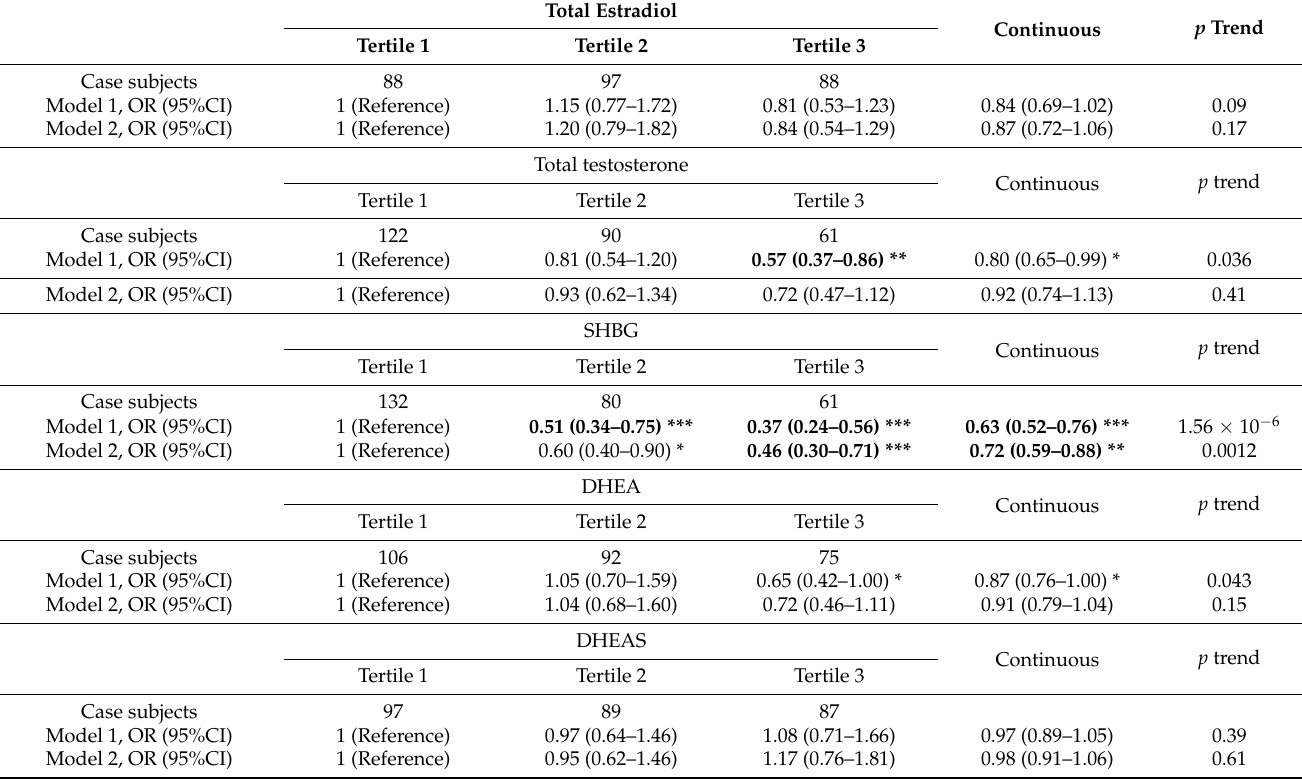
Table 2. Associations of sex steroids and SHBG with NAFLD among men. Total Estradiol